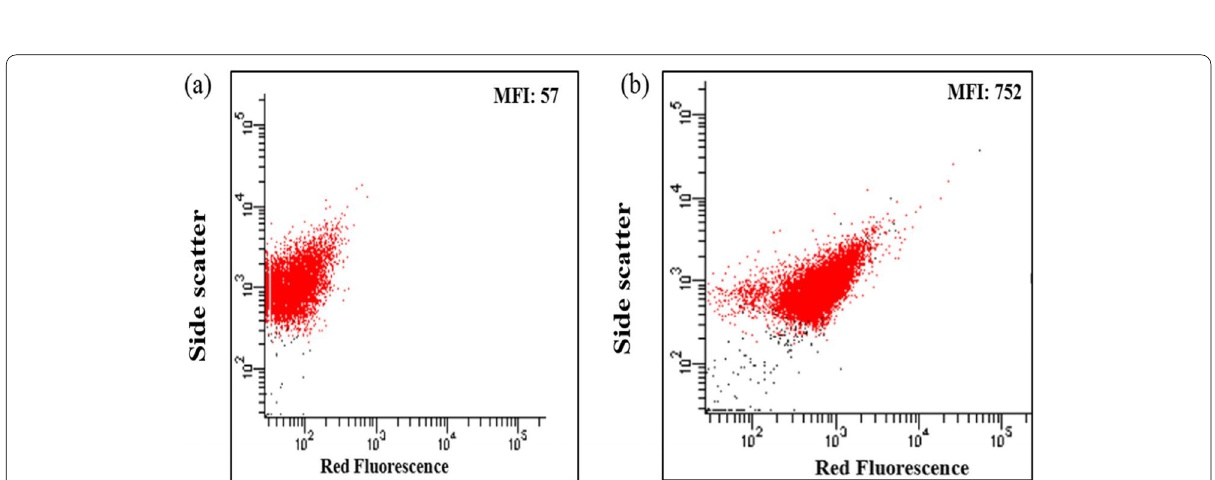
Fig. 3 Flow cytometer analysis of Bacillus sp. LPPI-18 stained with Nile blue A (0.5μg/L final concentration of NBA dye in Minimal Broth Davis broth). a Unstained culture of Bacillus sp. LPPI-18 for side scatter. b Stained culture of Bacillus sp. LPPI-18 for side scatter. The stained population increases from 57 to 752 indicating that 13.19 multiple fold increased after had been stained with